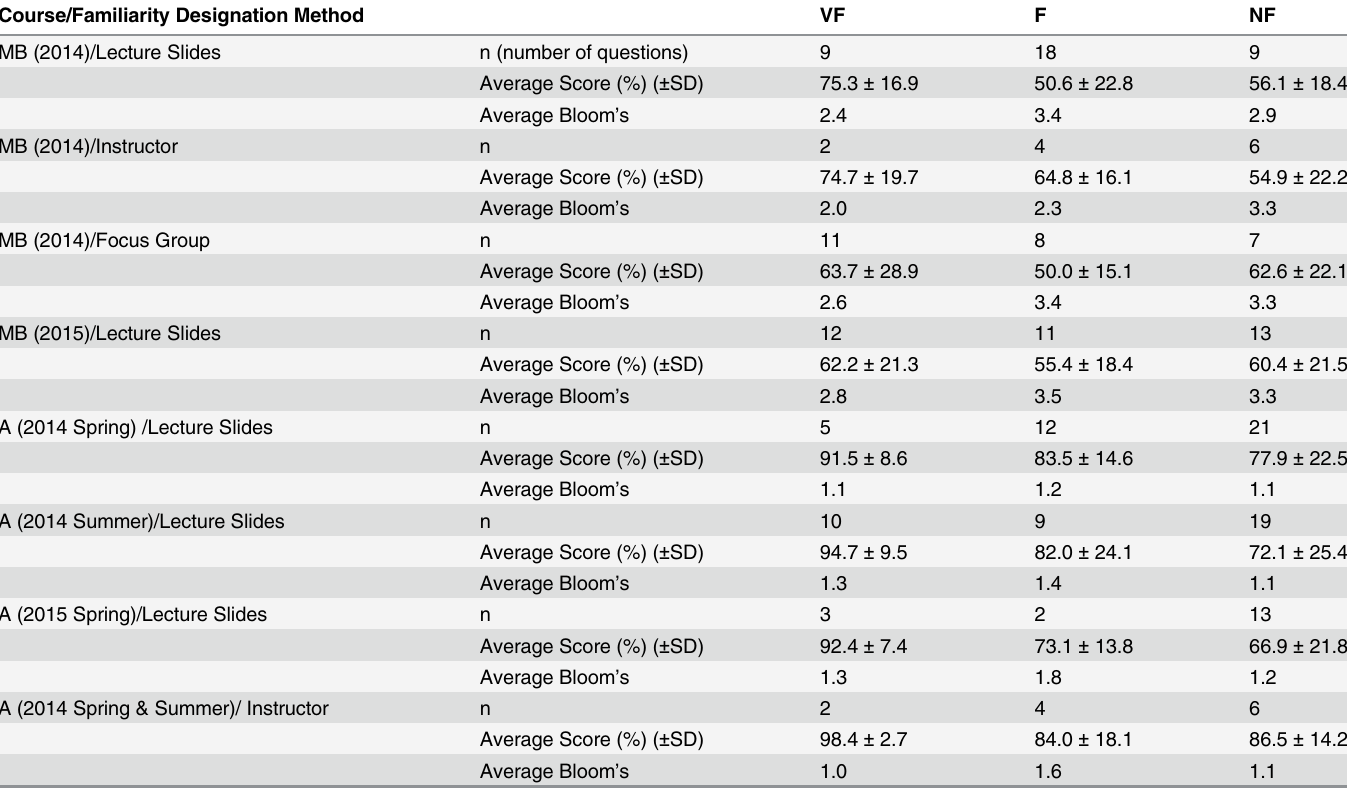
Table 2. Descriptive statistics of the questions analyzed for study